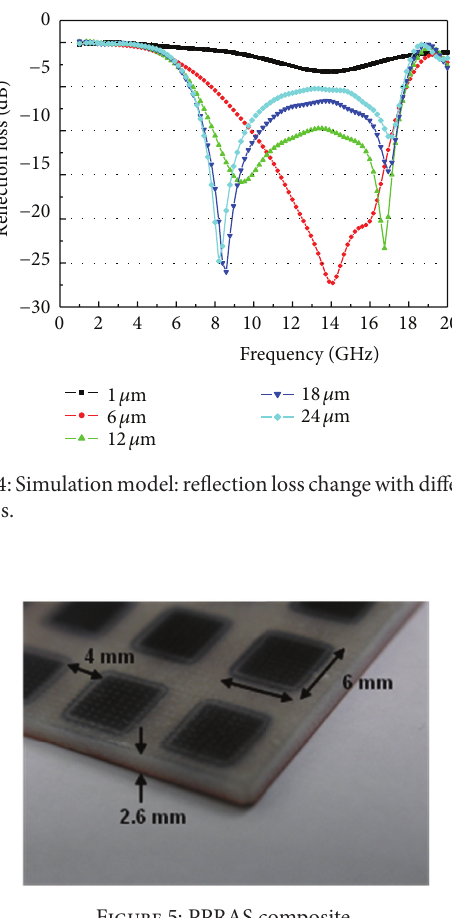
Figure 5: PPRAS composite.